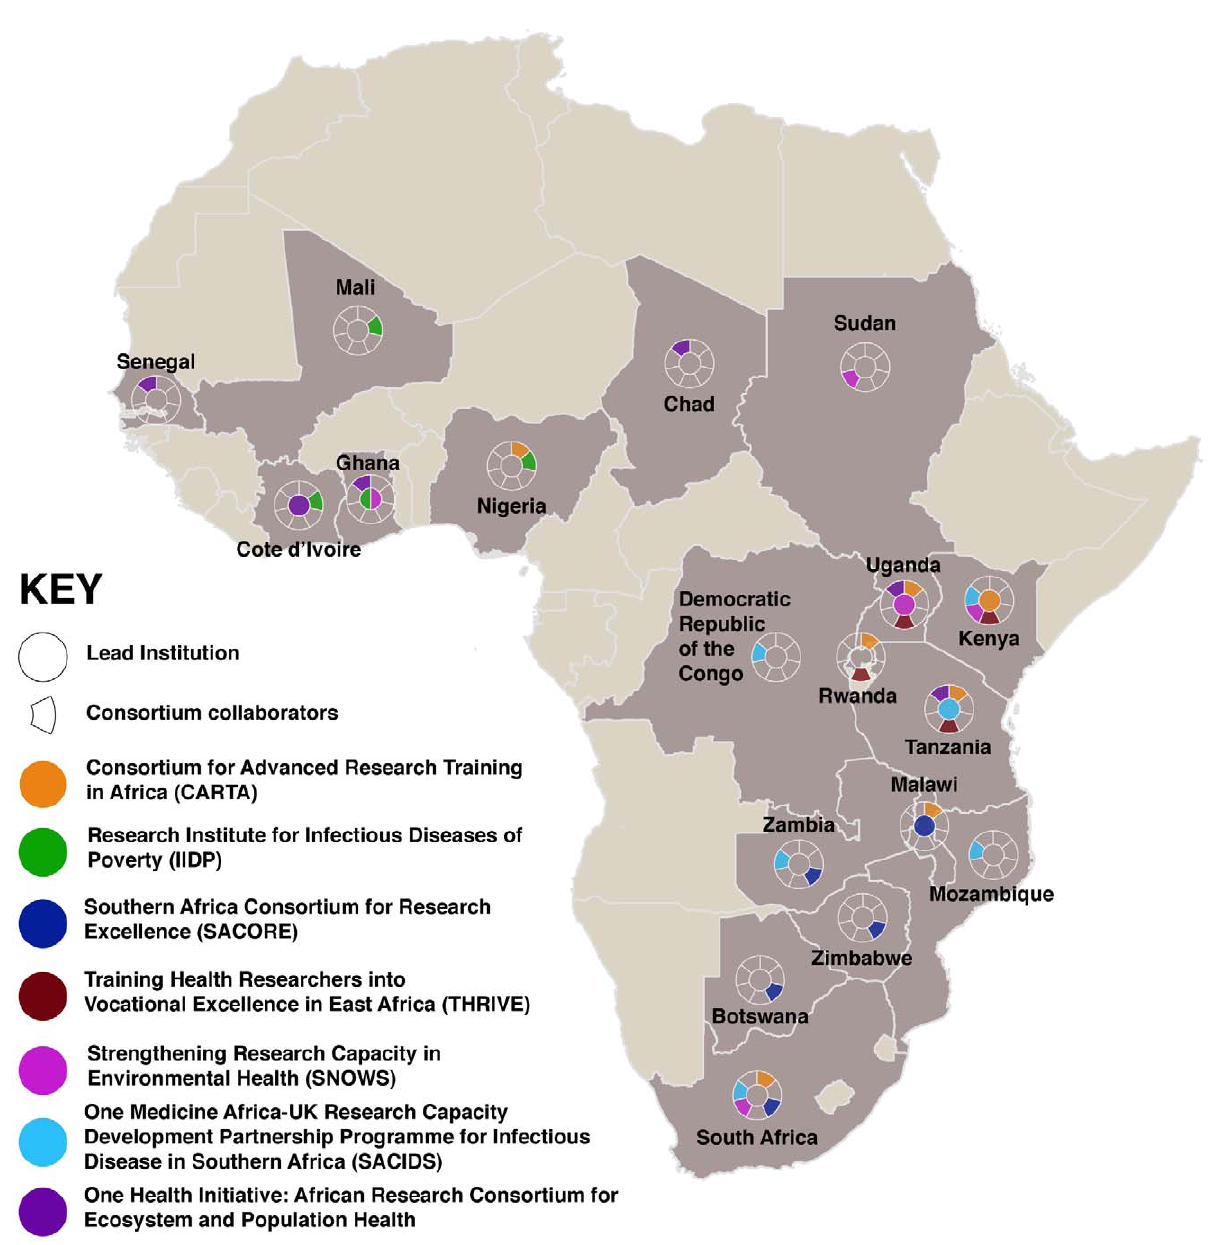
Figure 1. Countries and consortia in the African Institutions Initiative of The Wellcome Trust. (Redrawn from http://www.wellcome.ac.